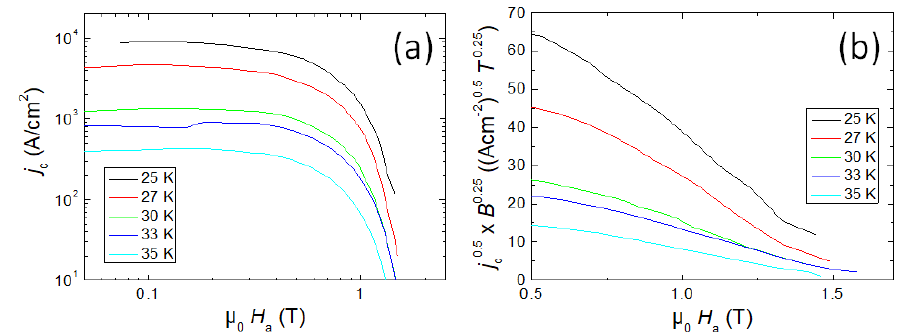
Figure 2. (a) double logarithmic plot of j c as function of the applied field, µ 0 H a . (b) Kramer plot of the same data set. the same data